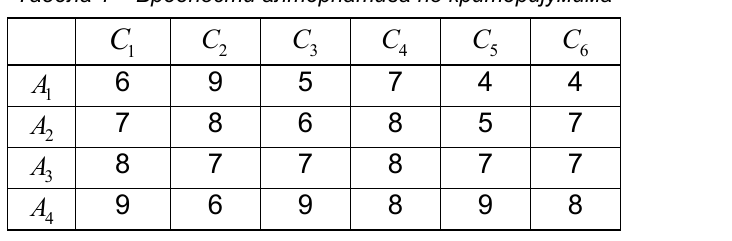
Table 1 – Criteria values by alternatives Таблица 1 – Значения альтернатив по критериям Табела 1 – Вредности алтернатива по